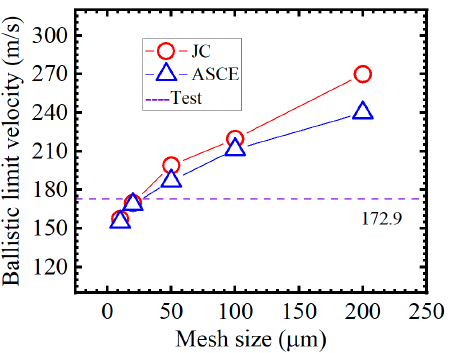
Figure 10. Mesh size sensitivity of BLV predicted using JC fracture criterion and ASCE fracture criterion.